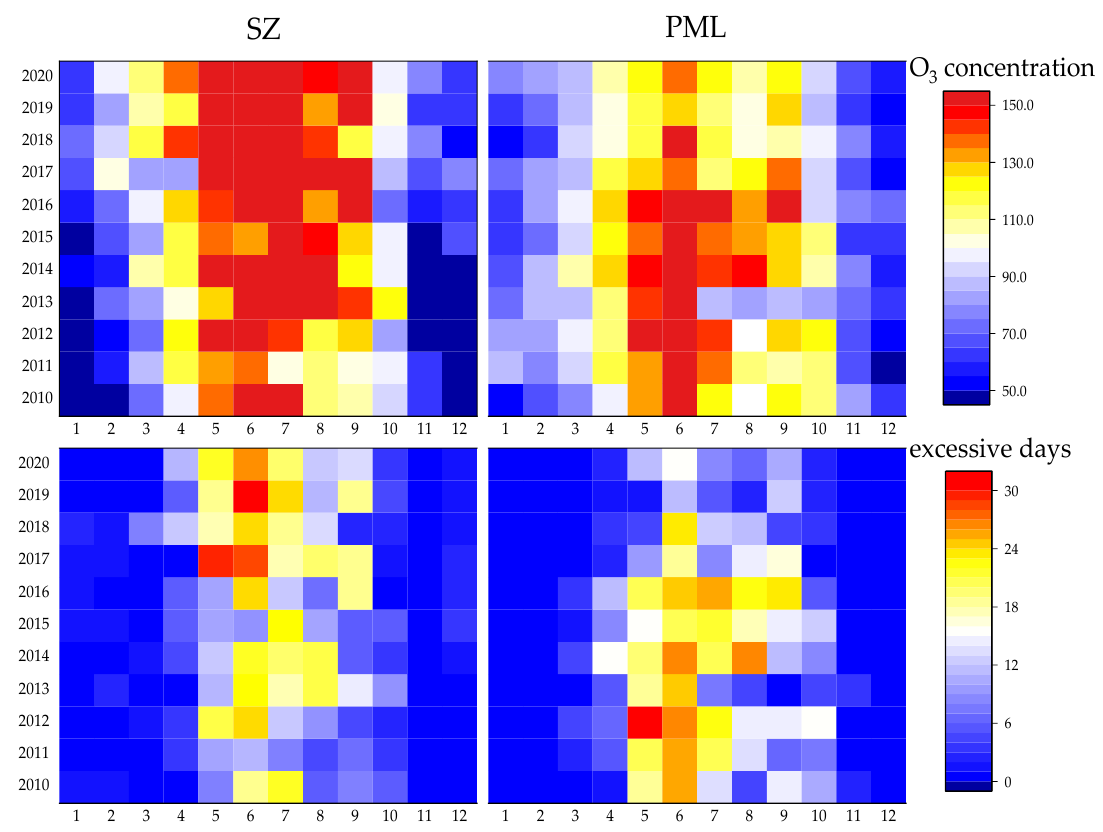
Figure 3. Monthly variations of MDA8 O 3 concentration and O 3 exceedance days in Jinan from 2010 to 2020, in urban (SZ) and suburban (PML) areas.